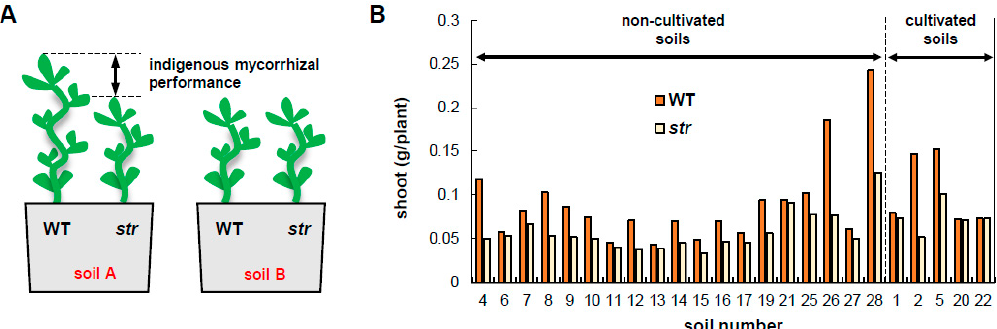
Figure 1. Bio-assay for evaluating the performance of indigenous arbuscular mycorrhizal fungi. ( A ) The schematic representation of the bio-assay. Three wild-type (WT) plants and three stunted arbuscule mutant ( str ) plants are grown in the same pot. The difference in shoot biomass between WT and str are the reflection of the performance of indigenous arbuscular mycorrhizal fungi (AMF) in the soils. ( B ) Shoot weights of WT and str plants grown for 20 days. Seventeen soils were obtained from non-cultivated sites that have not been used for cultivation at least for 5 years. Seven soils are obtained from sites that have been used for cultivation at least for 5 years.